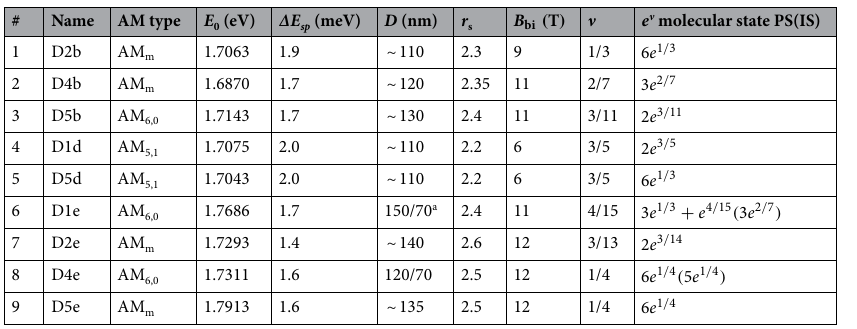
Table 1. Parameters of AM states of InP/GaInP 2 QDs measured using